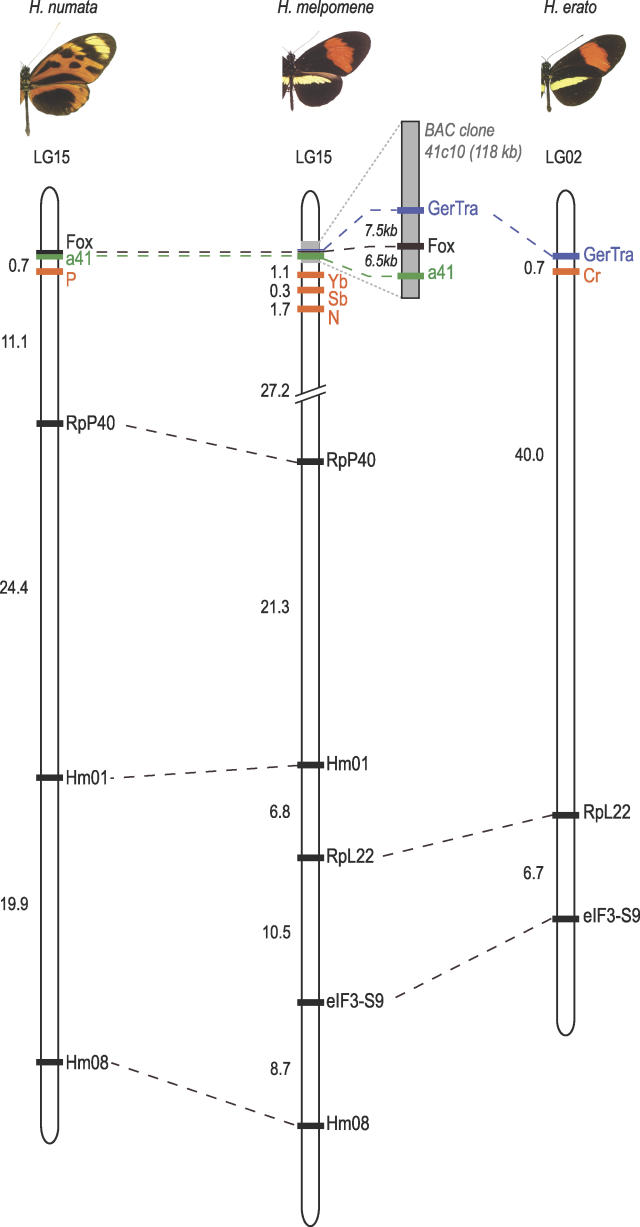
Chromosomal Maps for Linkage Group Homologues in H. melpomene (LG15), H. numata (LG15), and H. erato (LG02)Distances are in Haldane centimorgans. The alternative orders for P and a41 relative to Hm01 in H. numata are not significantly different (ΔLnL = −1.40). Similarly, most orders of N, Sb, Yb, and a41 in H. melpomene are not significantly different (from ΔLnL = −0.15 for the order a41–Yb–N–Sb– to ΔLnL = −0.77 for a41–N–Yb–Sb–). Finally, the two orders for Cr and GerTra in H. erato are also equally significant. Therefore, we here show the most likely gene orders but cannot exclude that the colour loci are on the other side of the anchor loci a41, Fox, or GerTra. In contrast, anchor loci order GerTra–RpP40–Hm01–Hm08 is robust, with alternative orders significantly worse (ΔLnL < −2), although the relative placement of RpL22 and eIF3-S9 is uncertain in H. melpomene and H. erato (ΔLnL > −2).